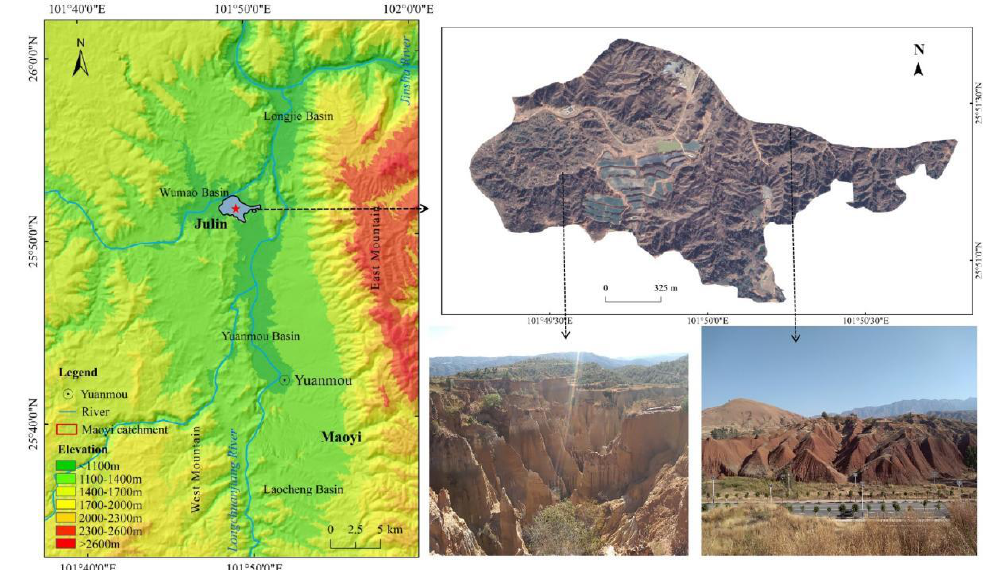
Figure 1. Location and landscape background of the study